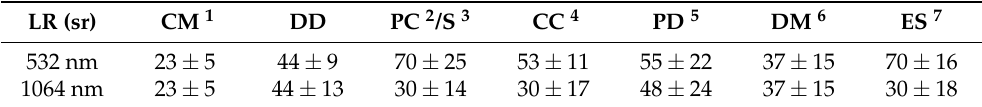
Table 1. Empirical LRs for different aerosol species used in the CALIOP inversion algorithm in version 4 at 532 and 1064